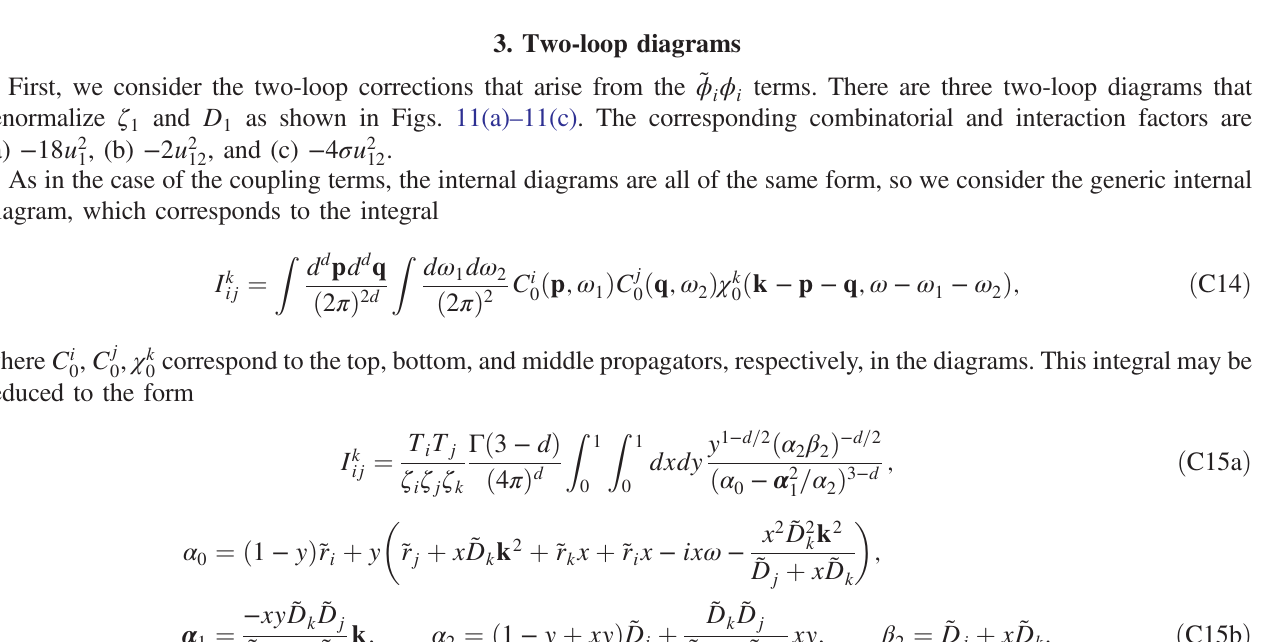
FIG. 11. Two-loop corrections to (a) – (c) ζ 1 and D 1 as well as (d,e) ζ 1 T 1 . Analogous diagrams for ζ 2 , D 2 , and ζ 2 T 2 can be obtained by switching thin black and thick cyan